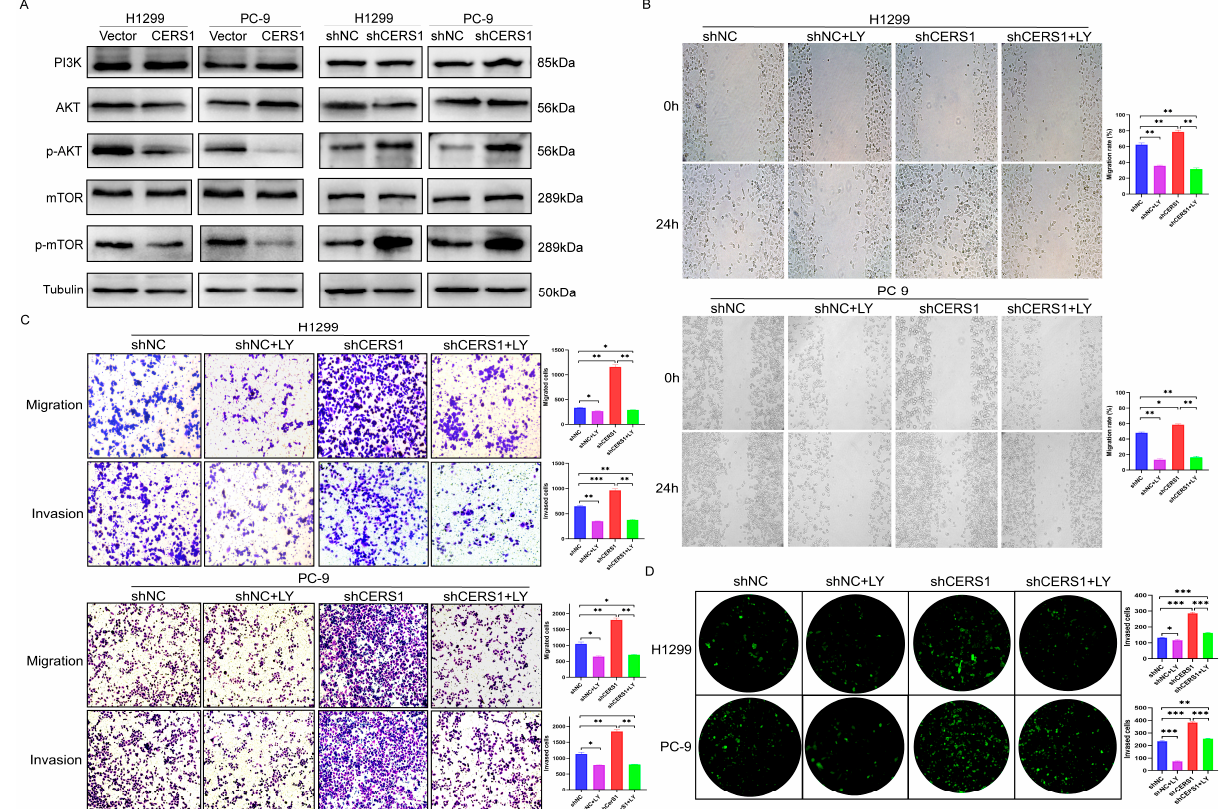
Figure 4. CERS1 expression a tt enuates the PI3K/AKT/mTOR signaling pathway. ( A ) Expression of indicated proteins was evaluated using western blo tt ing. ( B , C ) The e ff ect of LY294002 treatment on indicated proteins was evaluated using western blotting. ( B , C ) The effect of LY294002 treatment on the proliferation, migration, and invasion abilities of NSCLC cells stably transfected with shCERS1 was tested via wound-healing and transwell assays. ( D ) After adding LY294002, the ability of CERS1 knockdown cells to cross the BBB was assessed. * p < 0.05; ** p < 0.01; *** p <